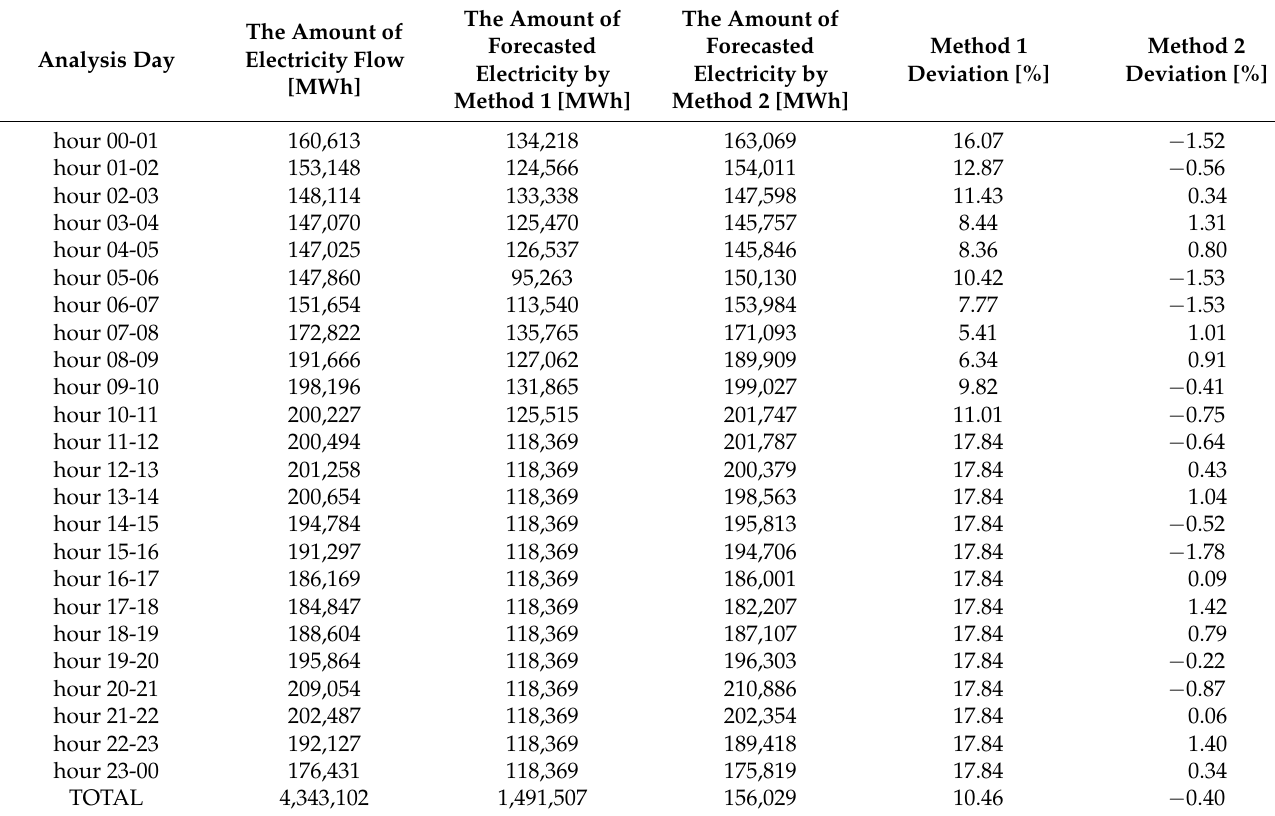
Table 2. Experimental measured data and optimized